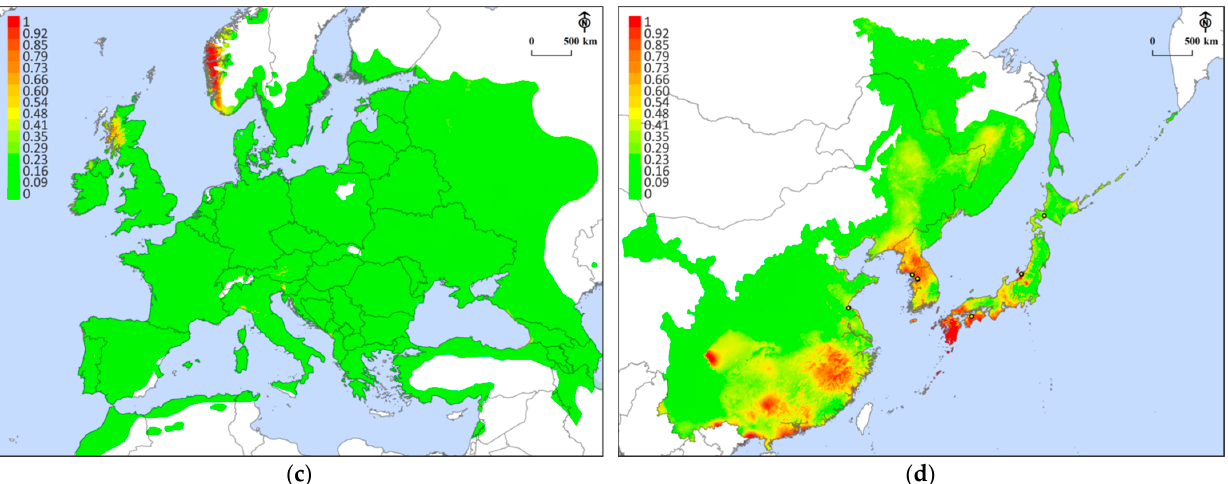
Figure 2. Habitat suitability maps modeled in Maxent and confirmed occurrences: ( a ) Phyllactinia fraxini in Europe, ( b ) P. fraxini in Southeast Asia, ( c ) P. fraxinicola in Europe, and ( d ) P. fraxinicola in Southeast Asia. The horizontal scale bar refers to the probability of distribution (1, high habitat suitability; 0, not suitable). White areas lie outside the natural distribution of Fraxinus host trees.